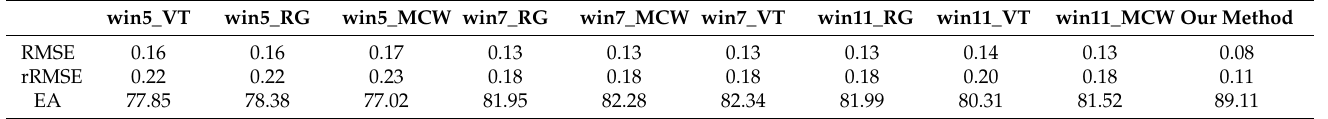
Table 4. The FCC-estimation accuracy of camphor pine